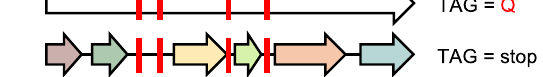
Fig. 2 | Protein sequence coverage map of alternative code phage tail-related protein. Highlighted sections of the code 15 predicted protein sequence (top) show the corresponding proteins that would have been predicted using standard code 11 (predicted open reading frames), also depicted in the graphical repre- sentation (bottom). Blue lines illustrate regions covered by tryptic peptides iden- ti fi ed through LC-MS/MS database matching, whereas gray lines represent regions